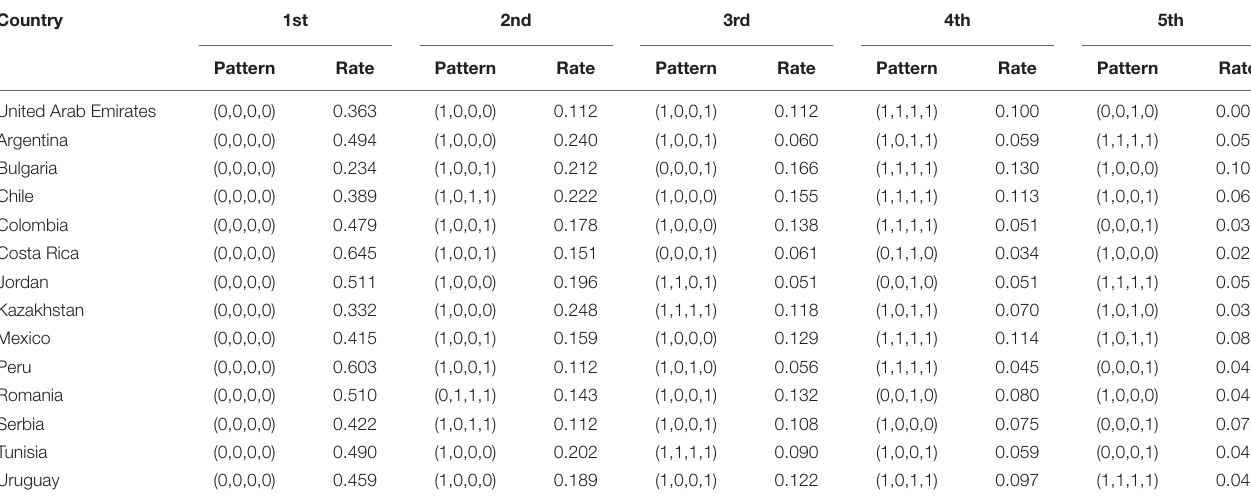
FIGURE 1 | Average of expected a posteriori of each attribute for all students in each country. TABLE 6 | The five most frequency patterns in each